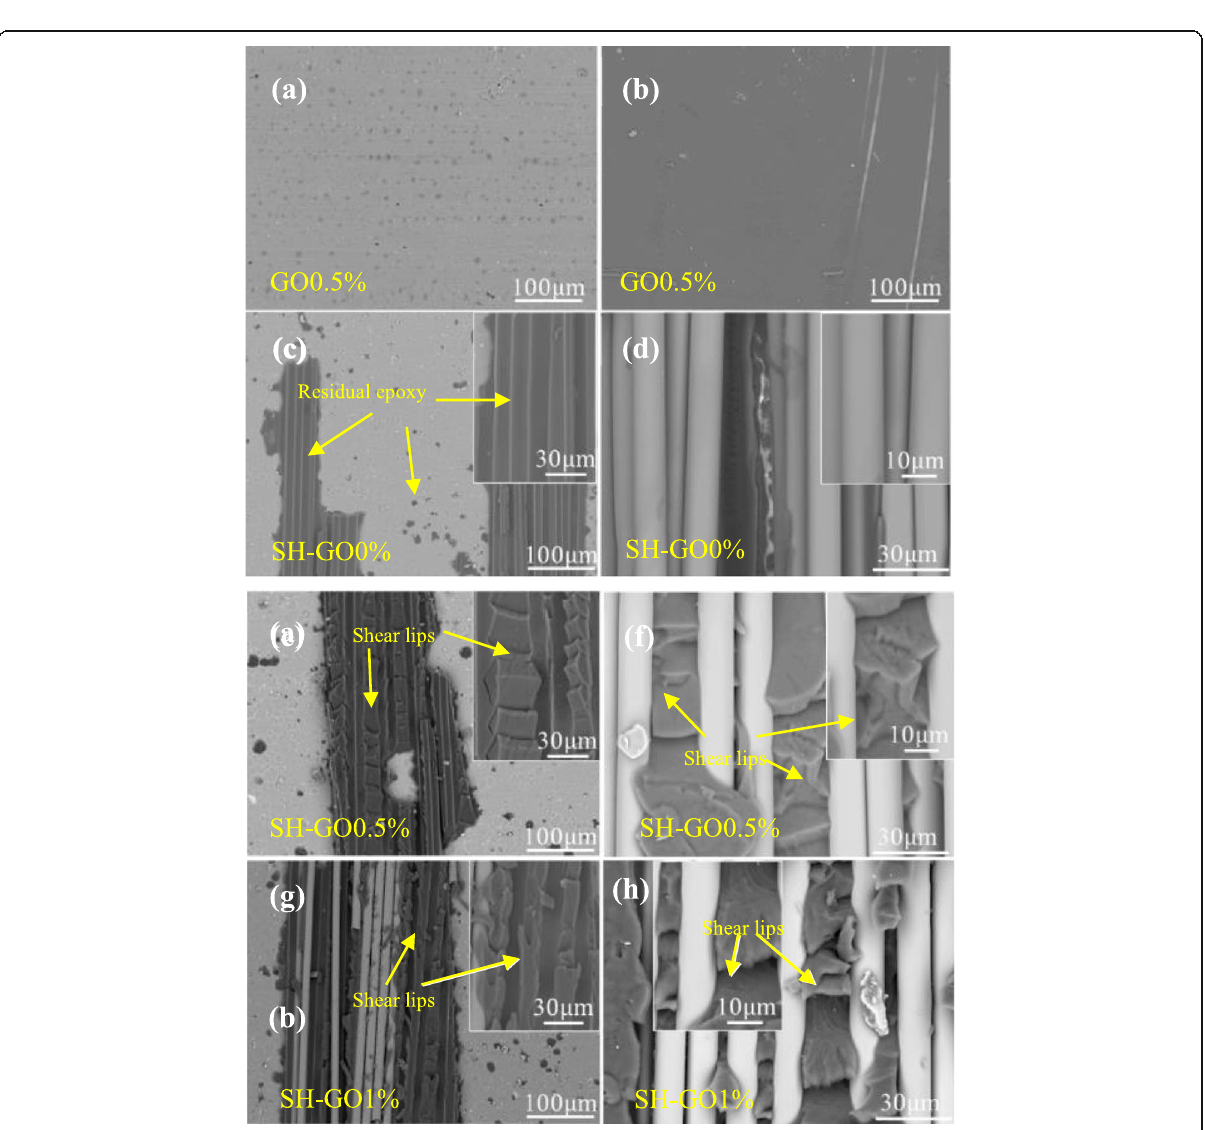
Fig. 15 Fracture surfaces of the mode-II GFRP/Al laminates. a , b GO0.5%. c , d SH-GO0%. e , f SH-GO0.5%. g , h SH-GO1% (left, the Al side; right, the composite